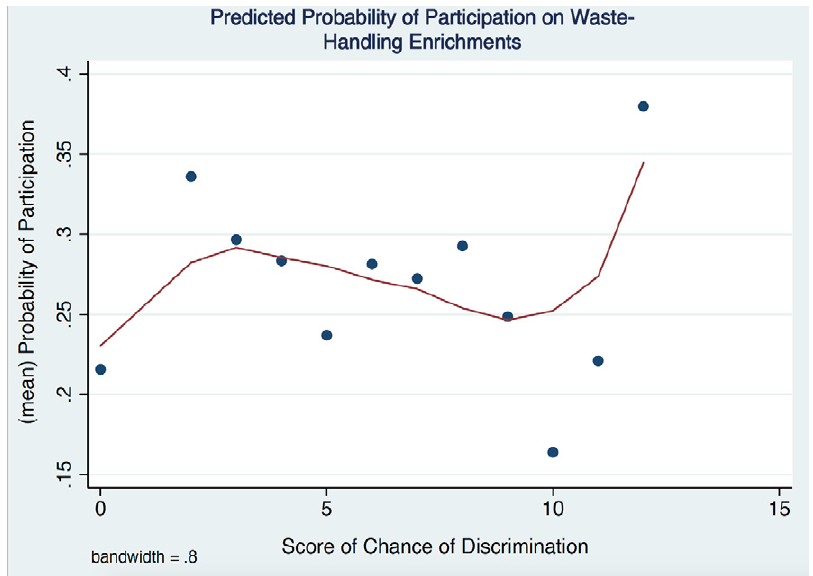
Fig. 2: Chance of Discrimination has fluctuated correlation over the probability of participation on waste-handling enrichments